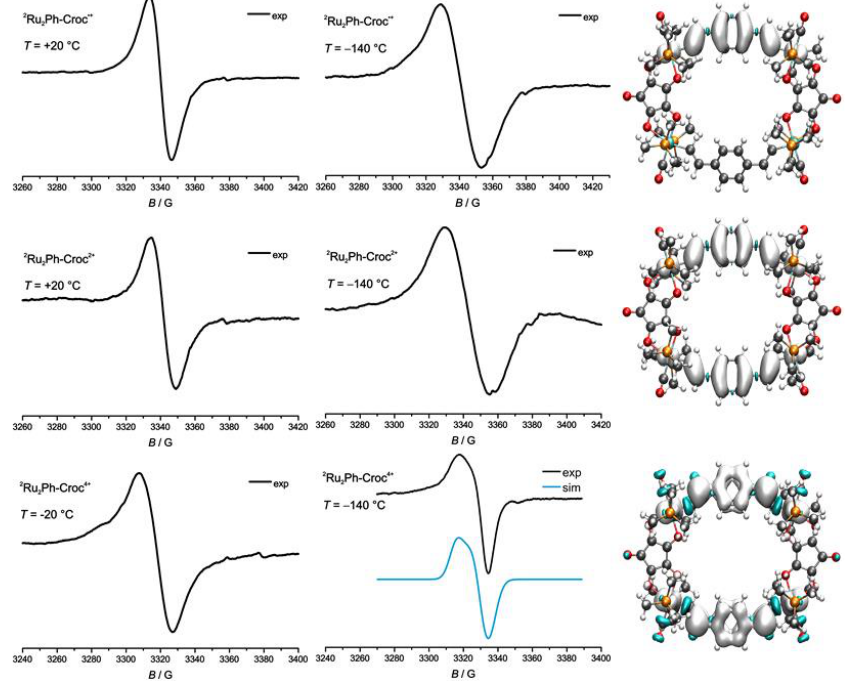
Figure 12. Experimental EPR spectra of 2 Ru 2 Ph-Croc + ( top left ), 2 Ru 2 Ph-Croc 2+ ( middle left ), and 2 Ru 2 Ph-Croc 4+ ( bottom left ) at +20 °C in CH 2 Cl 2 solution or at −140 °C in the frozen glass ( middle panel with simulated spectrum of 2 Ru 2 Ph-Croc 4+ in blue ( bottom middle ). Calculated spin density distribution in 2 Ru 2 Ph-Croc + ( top right ), 2 Ru 2 Ph-Croc 2+ ( middle right ), and 2 Ru 2 Ph-Croc 4+ ( bottom right